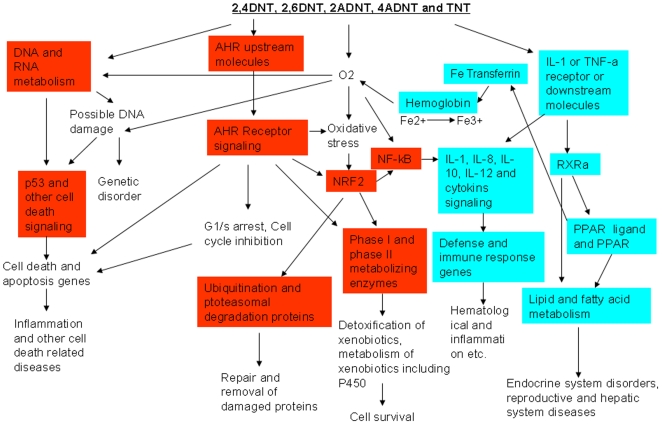
An integrated network model to explain the molecular mechanisms of hepatoxicity induced by the compounds.Environmental chemicals, gene functional terms, pathway cross talks, gene networks, and physiological endpoints were integrated to form a network at the system level to account for the molecular mechanisms of hepatoxicity mediated by these compounds. Red and green highlighted functional terms, genes, and pathways were generally up-regulated and down-regulated respectively by these compounds.